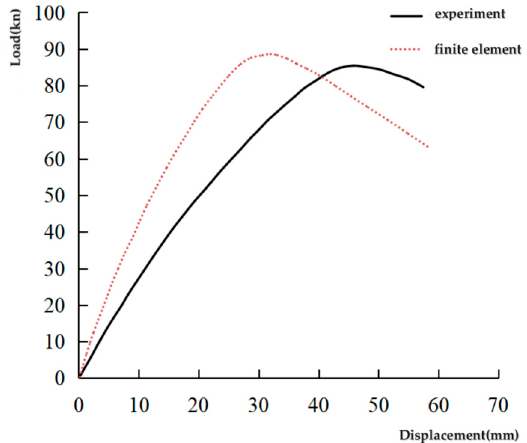
Figure 4. Comparison of JD-1 load-displacement curves.